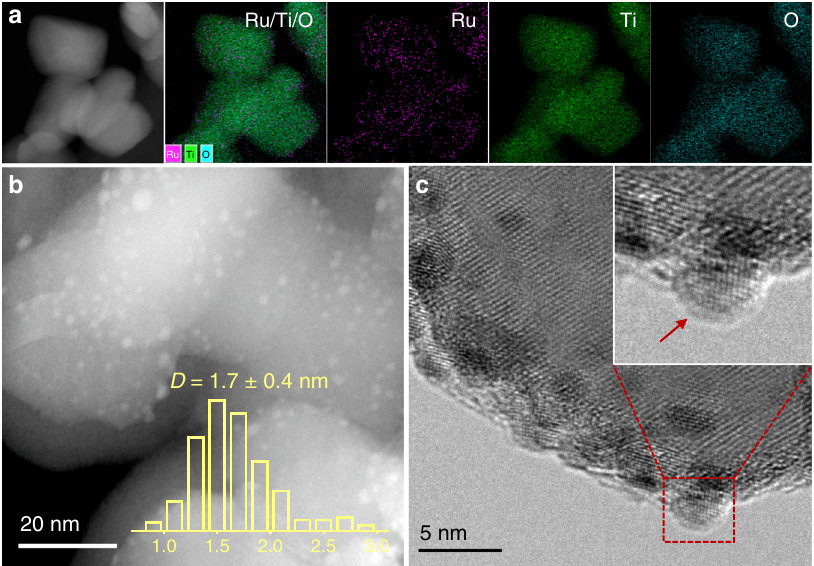
Fig. 1 Morphological study of the Ru/TiO 2 catalysts. a Elemental mapping of Ru/Ti/O in the fresh Ru/TiO 2 catalyst. b HAADF-STEM image of the Ru/ TiO 2 catalyst pretreated at 600 °C (Ru/TiO 2 -600 sample) with the metal size distribution. c HRTEM image of the Ru/TiO 2 -600